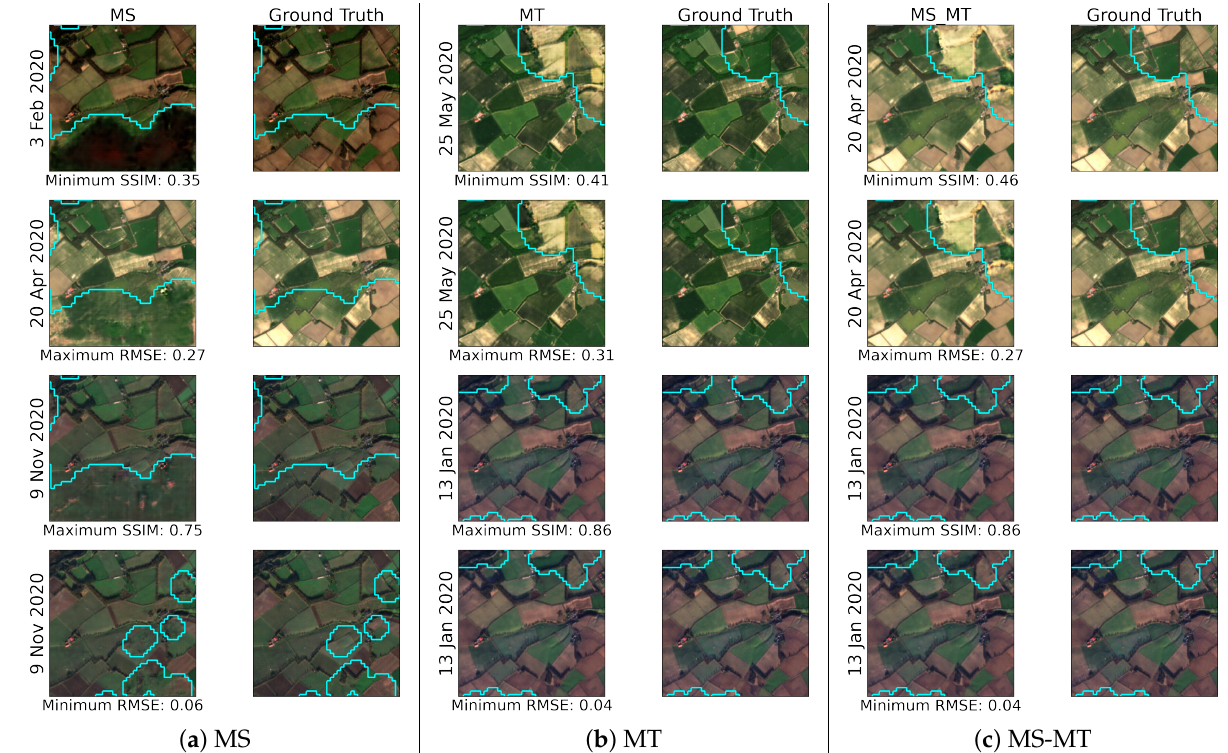
Figure 9. Reconstructions with the lowest (top two rows) and highest (bottom two rows) performance for both the SSIM and RMSE for the Scotland region. Each row contains all three stacked modes (MS, MT, and